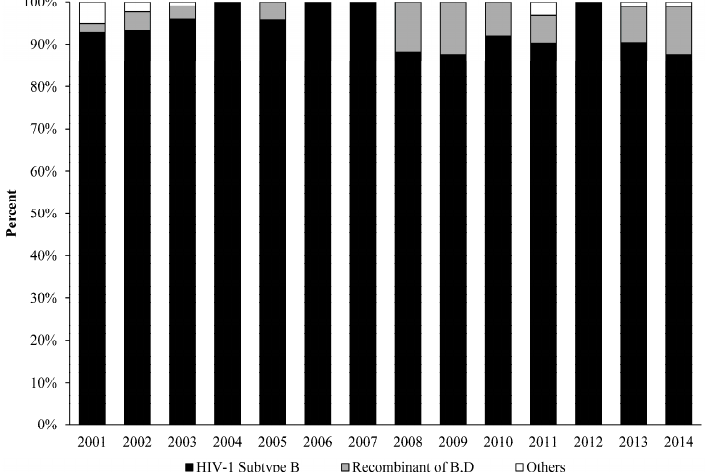
Figure 2. REGA (version 3) sub-typing analysis revealed a high prevalence of HIV-1 B-clade and recombinants, including subtype B (92.8%) and B/D recombinant (5.9%). A much smaller number of cases also involved (1.3%); subtype A (A1), A (01-AE), A (A2-like), CRF-39 BF-like, recombinant 39-BF/D, and others. Some of the recombinants appeared as early as in 2001.